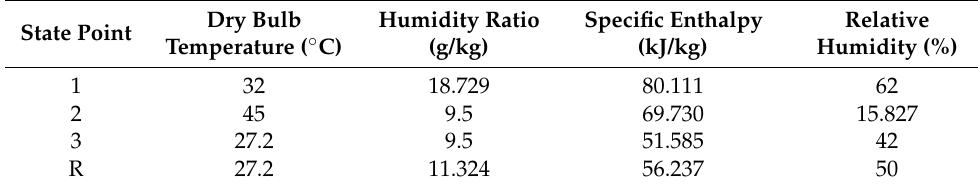
Figure 7. Psychrometric chart for dehumidification in DDS. Table 7. Air state parameters for dehumidification in